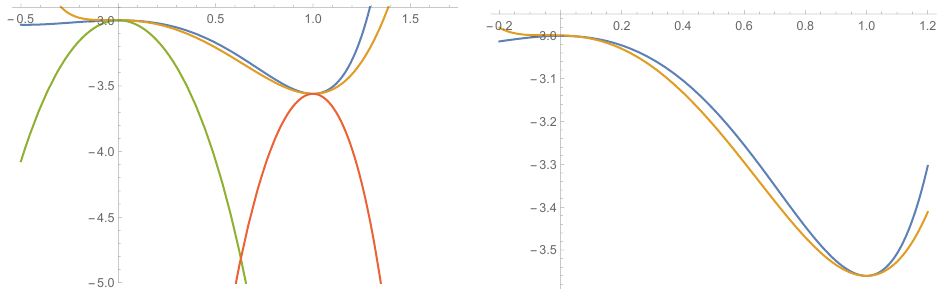
Figure 4. The profile of the scalar potential restricted to the straight line connecting vacua “1” and “3” (blue curve). Besides the previously determined globally bounding functions (in orange and green), we also plot − 3 f 2 (yellow curve), having both critical points as local extrema, and thus defining DW 13 the interpolating flow (zoomed on the right). The plots are both drawn in (cid:96) = 1